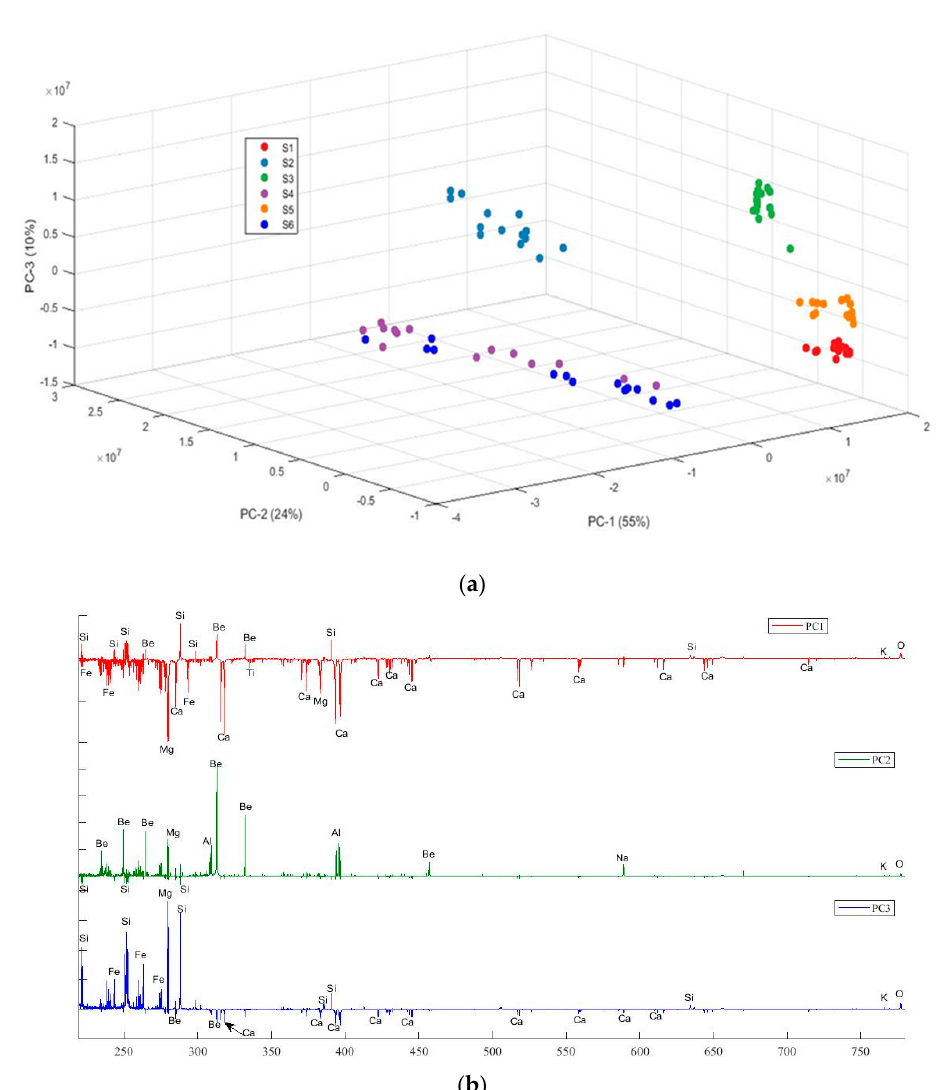
Figure 10. ( a ) 3-D score plot of PCA plotted for LIB spectral data of gemstone samples; ( b ) loading plot of the first three PCs from PCA applied to LIB spectral data of gemstone samples.